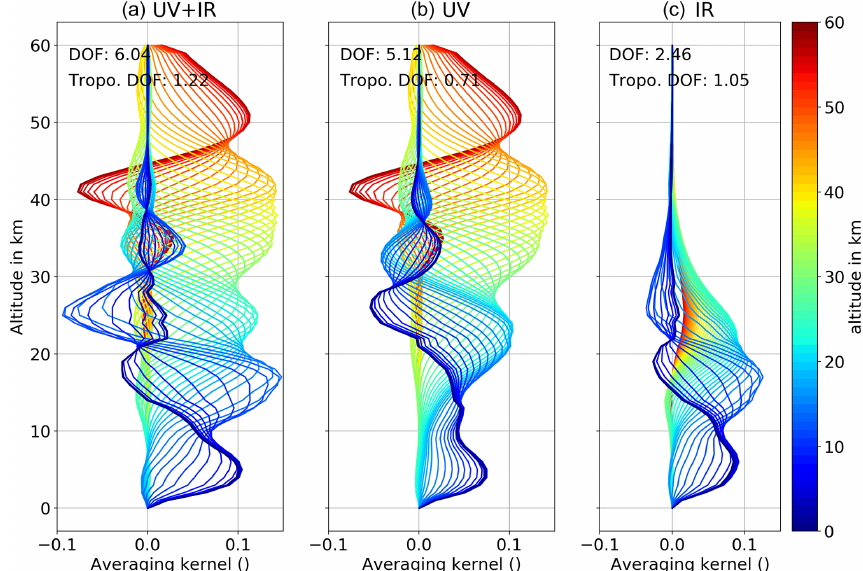
Figure 3. Rows of the averaging kernel matrix for the three retrievals shown in Fig. 2. Each line represents the sensitivity of the ozone profile retrieval at a certain altitude level from 0km (blue) to 60km (red). DOF is given by the sum of the averaging kernel (AK) matrix main diagonal. The tropopause is defined by 2PVU from ERA5 reanalysis.